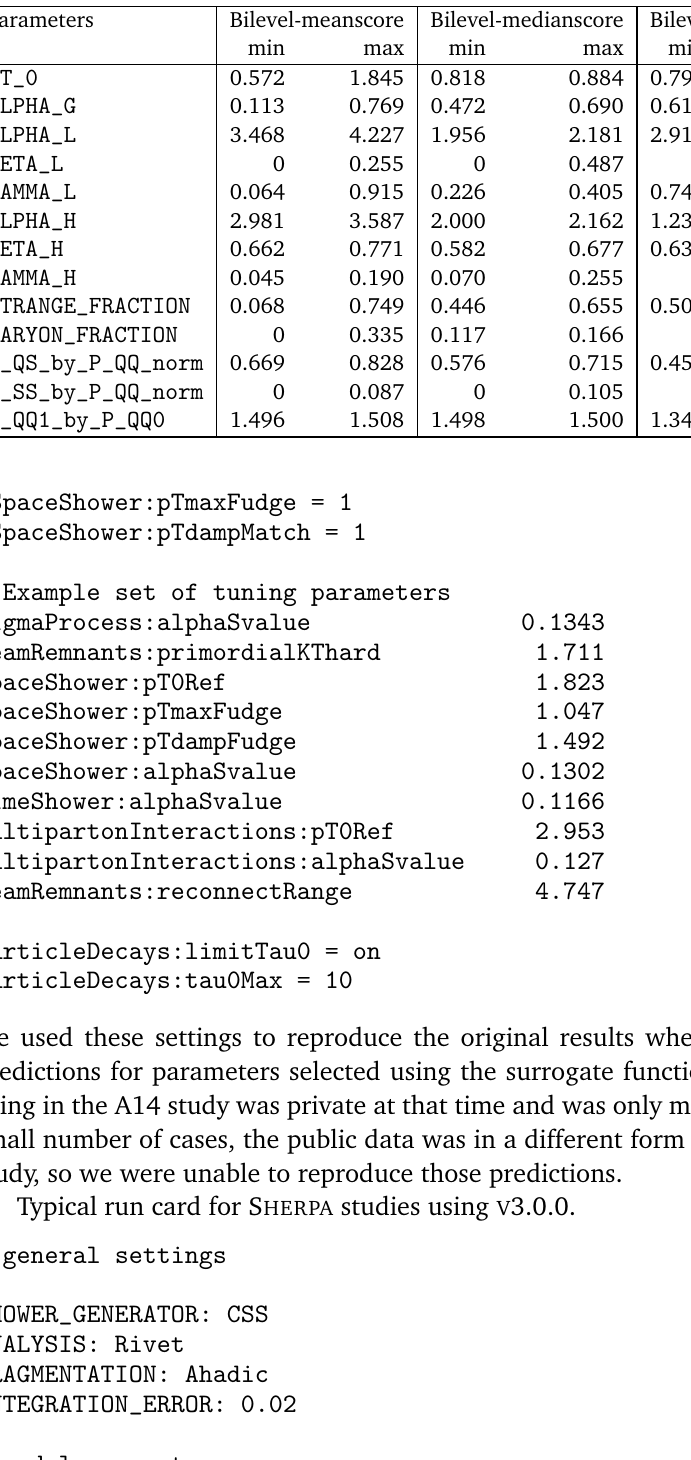
Table 34: Eigentune results for the S HERPA dataset using the optimal physics pa- rameters p ∗ obtained with the different optimization methods when using the cubic polynomial